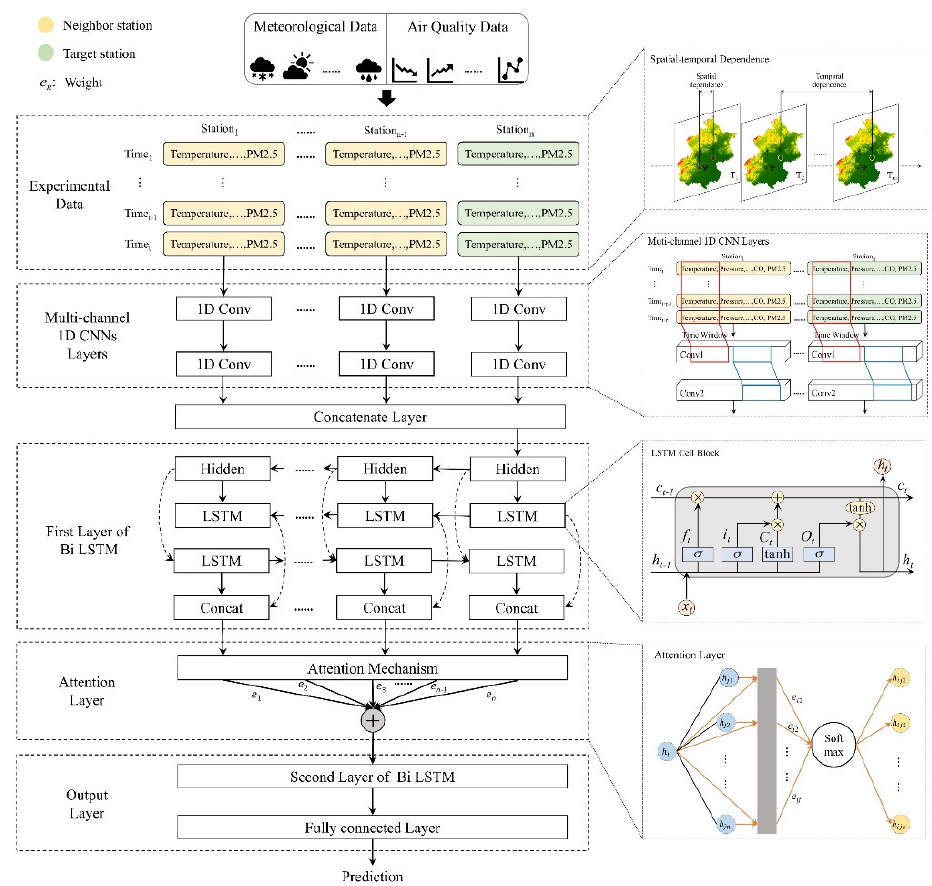
Figure 1. Structural components of the FPHFA model.